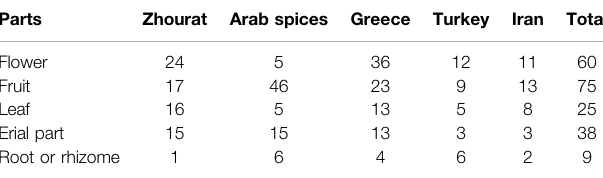
TABLE 2 | Parts of the plant from which the plant ingredients